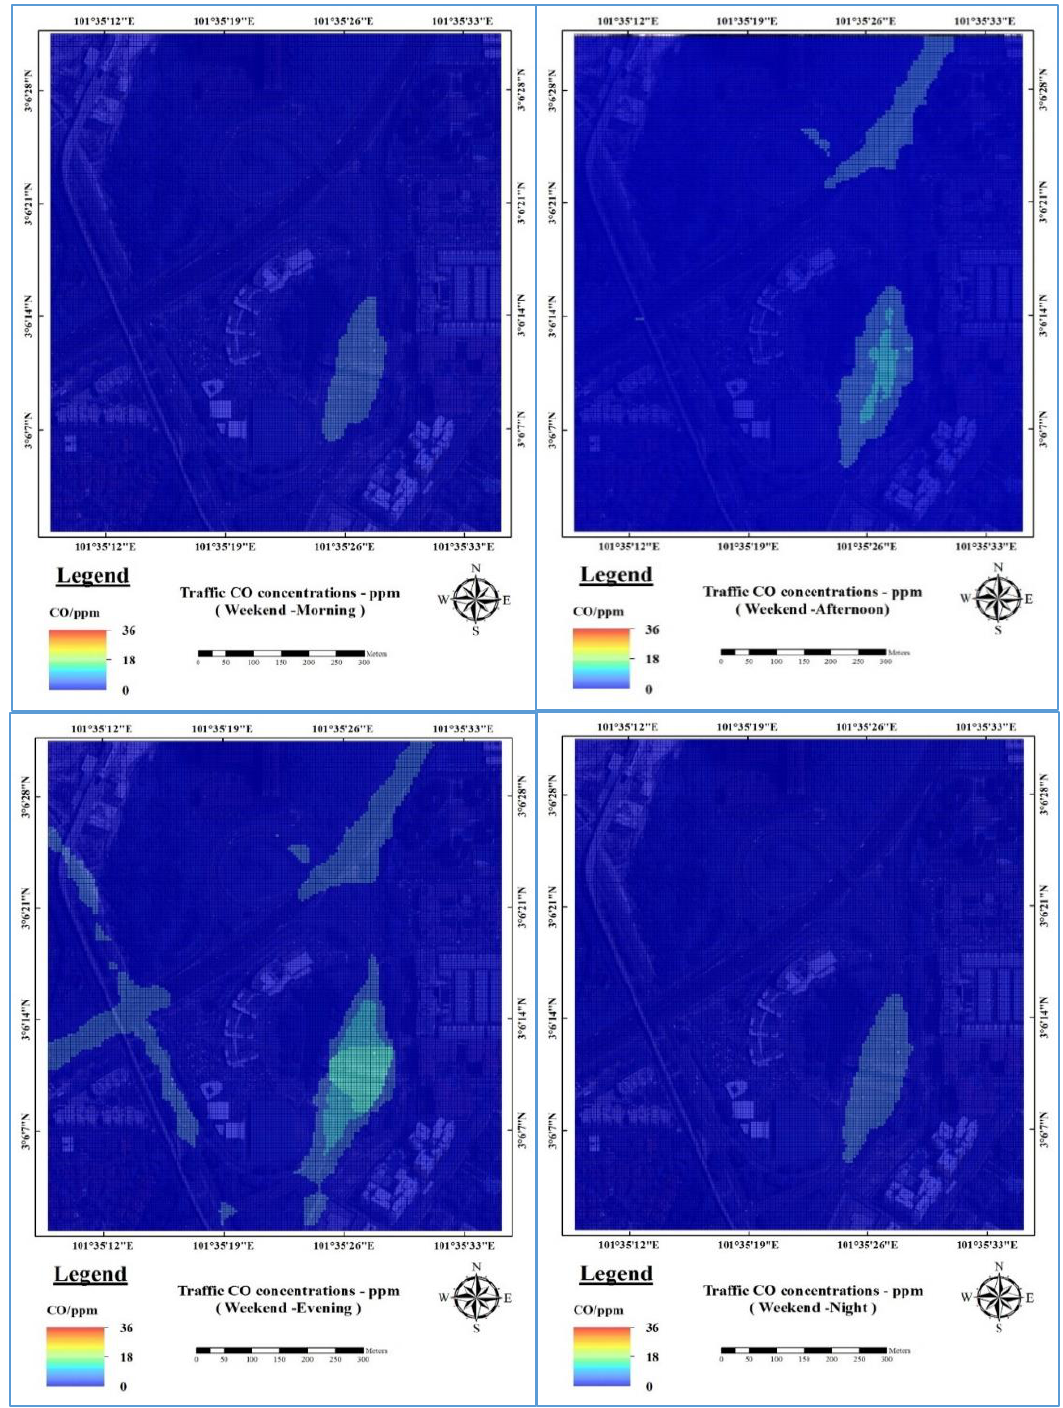
Figure 6. Prediction maps during the weekend at different times (morning, afternoon, evening and night).